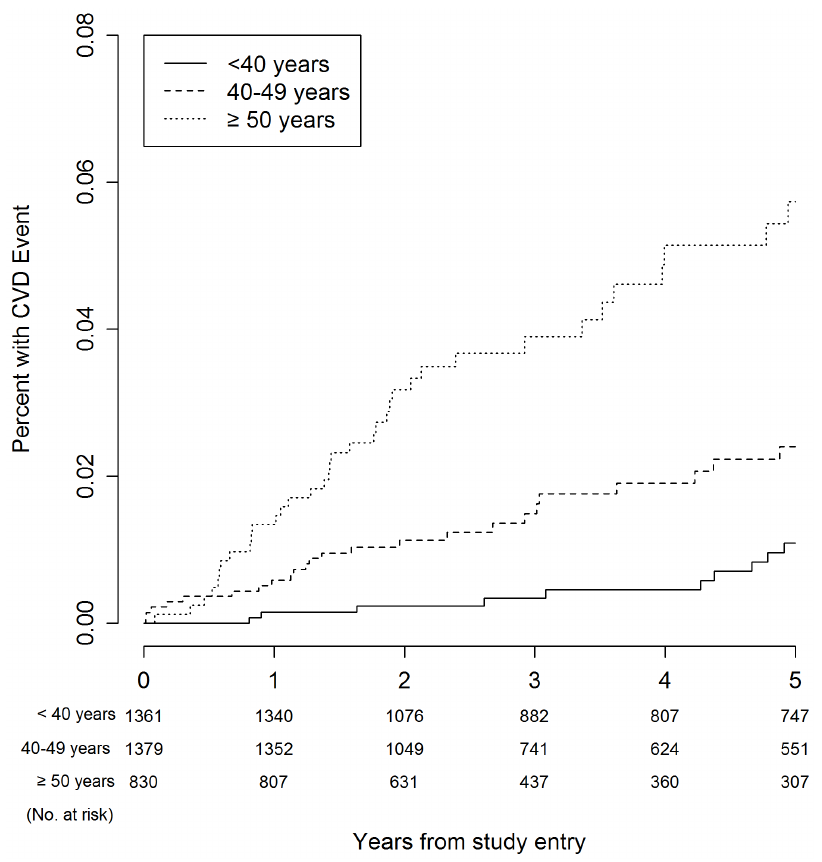
Figure 4. Cumulative probability of CVD event by age group.